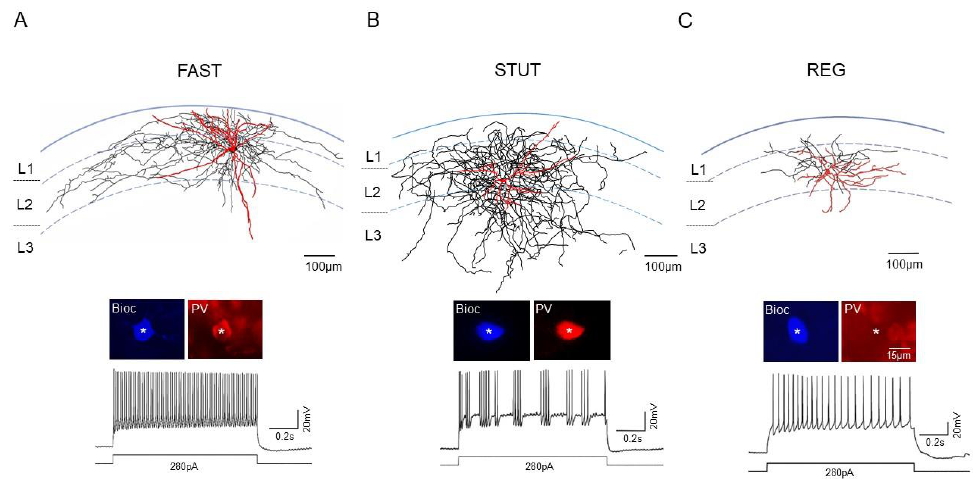
Figure 1. The properties of morphologically and immunocytochemically identified interneurons. ( A – C , upper ) Neurolucida reconstruction of the biocytin-filled representative PV-immunopositive FAST ( A ) and STUT ( B ) as well as PV-immunonegative REG ( C ). Dendrites are shown in red and axons in black. These INs were selected in GFP mice based on the fluorescence signals before they underwent final identification via immunostaining for PV ( A – C , insert, somas are marked with asterisk). ( A – C , bottom ) Examples of FAST, STUT, and REG voltage responses to depolarizing current steps of 280 pA. Note a typical fast ( A ), stuttering-like ( B ), and regular ( C ) firing of FAST, STUT, and REG, respectively.